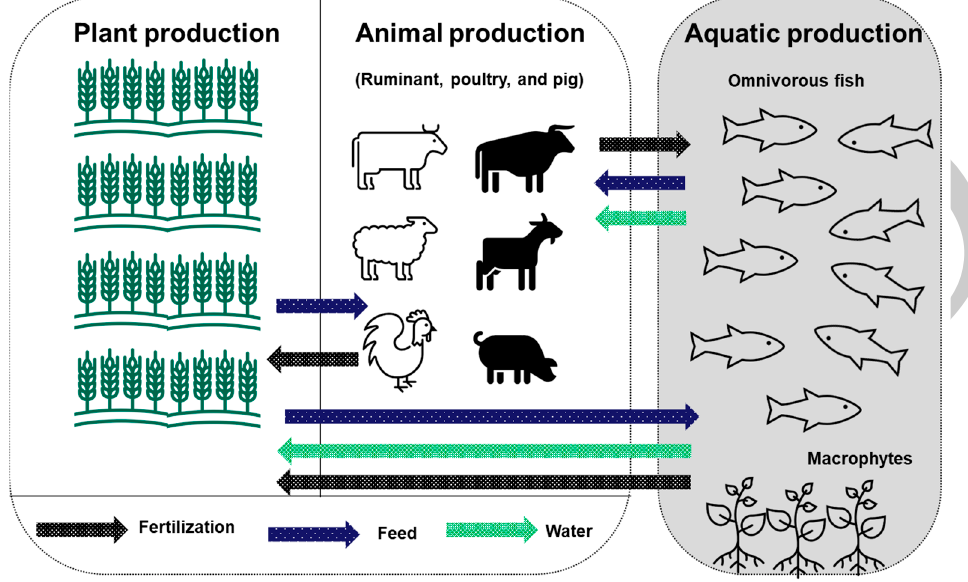
Figure 3. Schematic representation of an aquaculture system based on enhanced species complementarity via trophic interactions among the farmed species. This system integrated agriculture–aquaculture associated with terrestrial farming units and aquaculture systems. Herein, nutrient recycling is systematized among farm components, including terrestrial crops, co-products, livestock feed, and nutrients for aquatic settings (zooplankton and phytoplankton) as reported in the previous report [37].